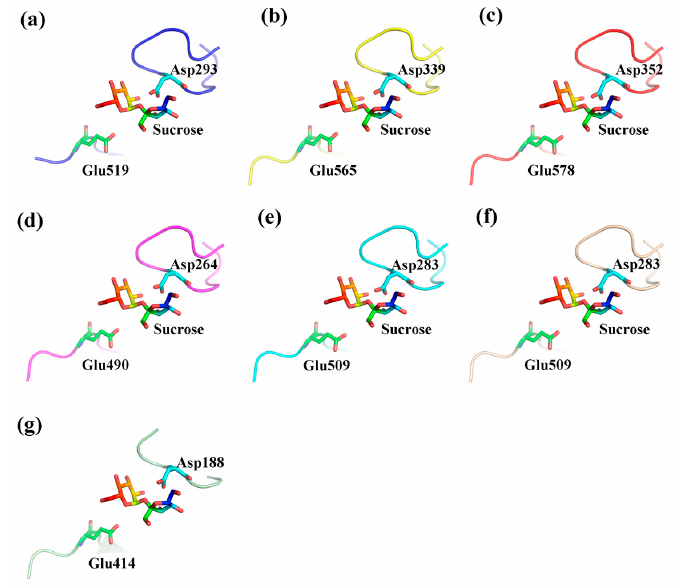
Figure 6. Cartoon representation of the predicted three-dimensional structure models of CaNINV1–6. ( a ) CaNINV1; ( b ) CaNINV2; ( c ) CaNINV3; ( d ) CaNINV4; ( e ) CaNINV5; ( f ) CaNINV6; and, ( g ) NINV protein from Anabaena ; ( h ) the monomer of CaNINV1. The six subunits are sequentially labeled as A–F. The spherical structures indicate sucrose molecules. The image was generated using the PyMOL program (Schrödinger, Inc., New York, NY, USA).